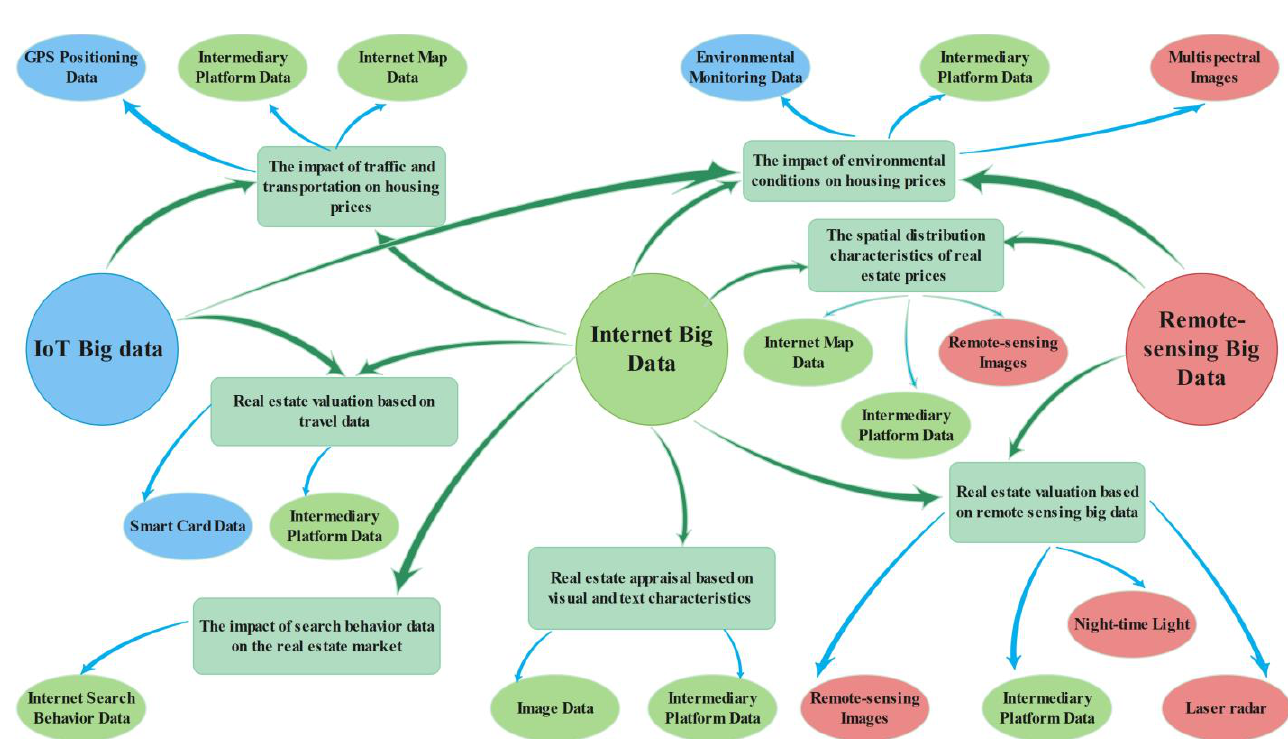
Figure 2. Big data atlas for real estate appraisal. Table 1. Typical big data applied in real estate appraisal.